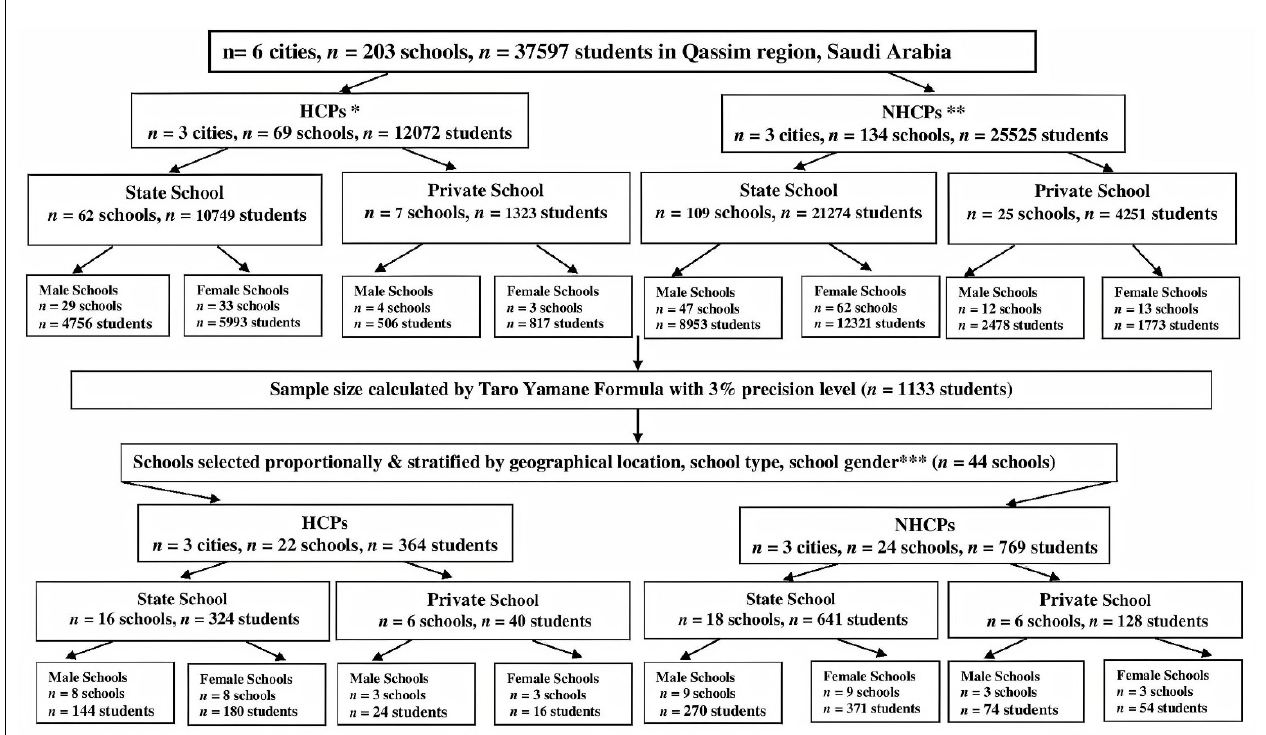
Figure 1. The sampling frame and sampling.